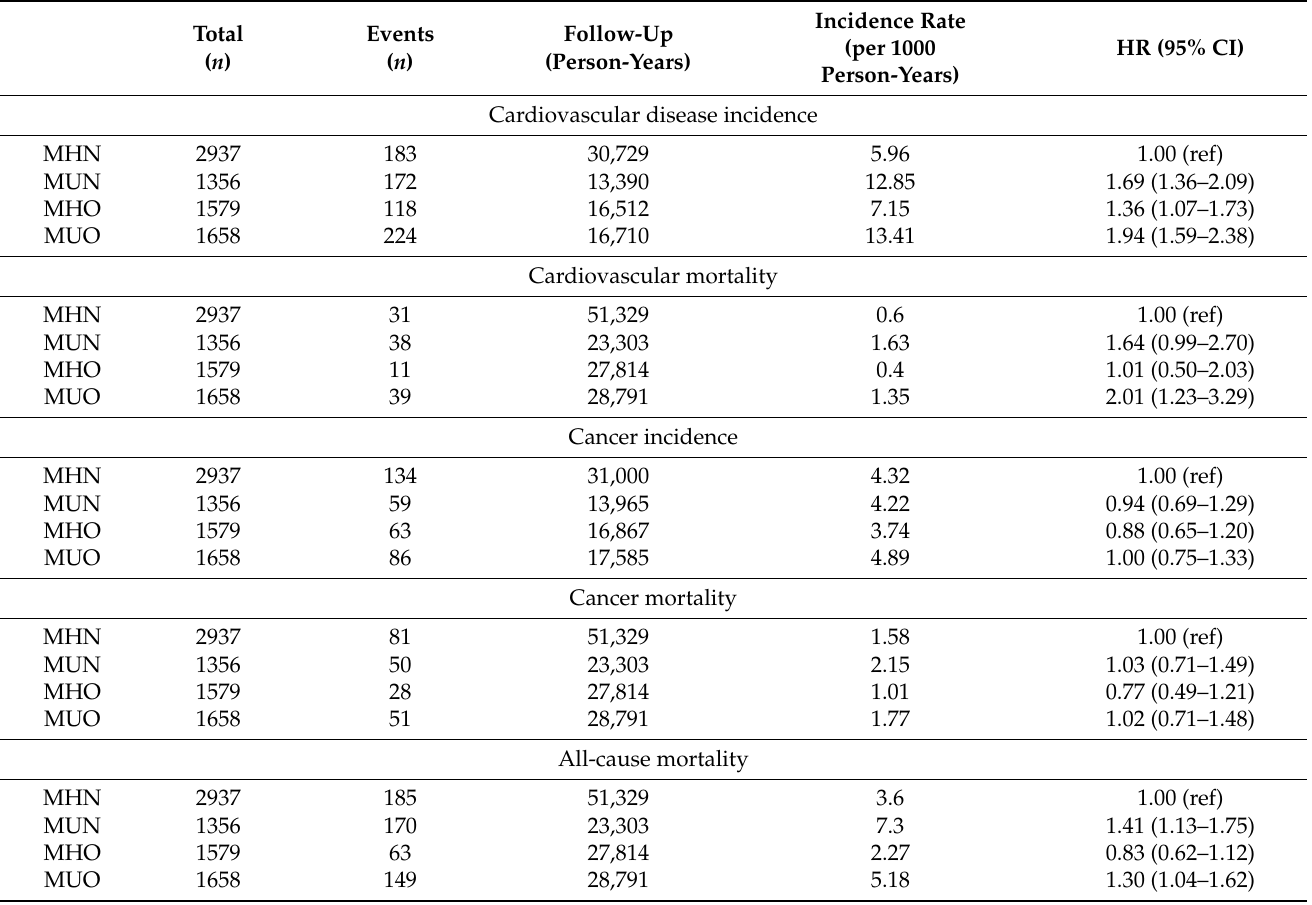
Table 4. Hazard ratios (HRs) and 95% confidence intervals (Cis) for the cardiovascular disease incidence and mortalities according to the combination of metabolic health risks and obesity status in